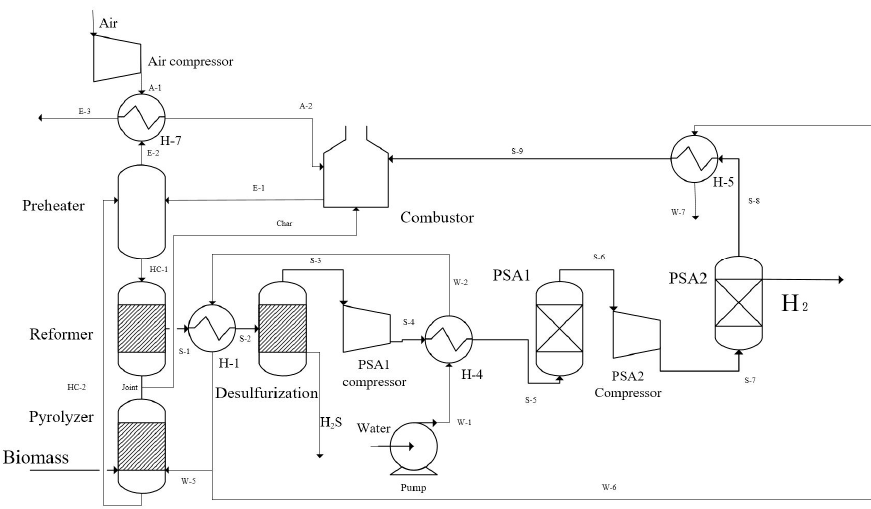
Table 1. The parameters used in the Pt degradation model.